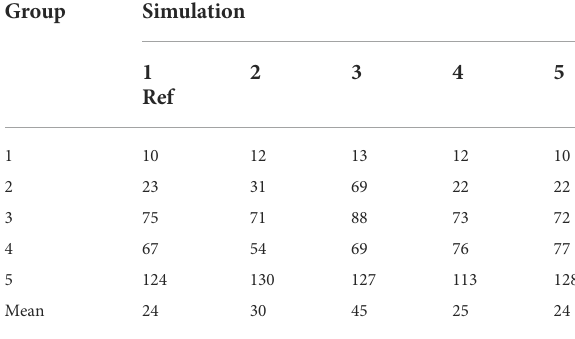
TABLE 6 CRE numerical results (%). Group